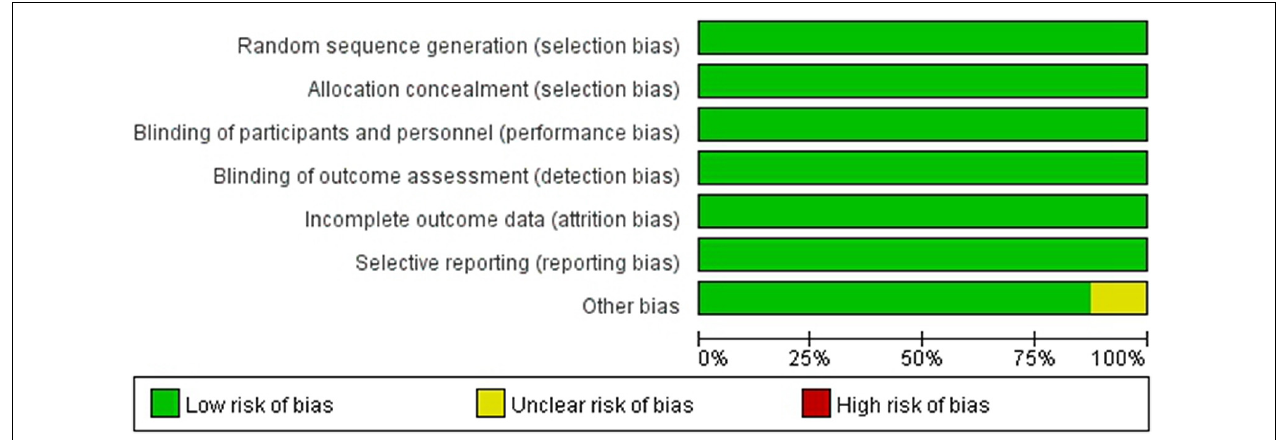
FIGURE 2 | Methodological quality graph: author’s judgments about each methodological quality item presented as a percentage across all included studies.